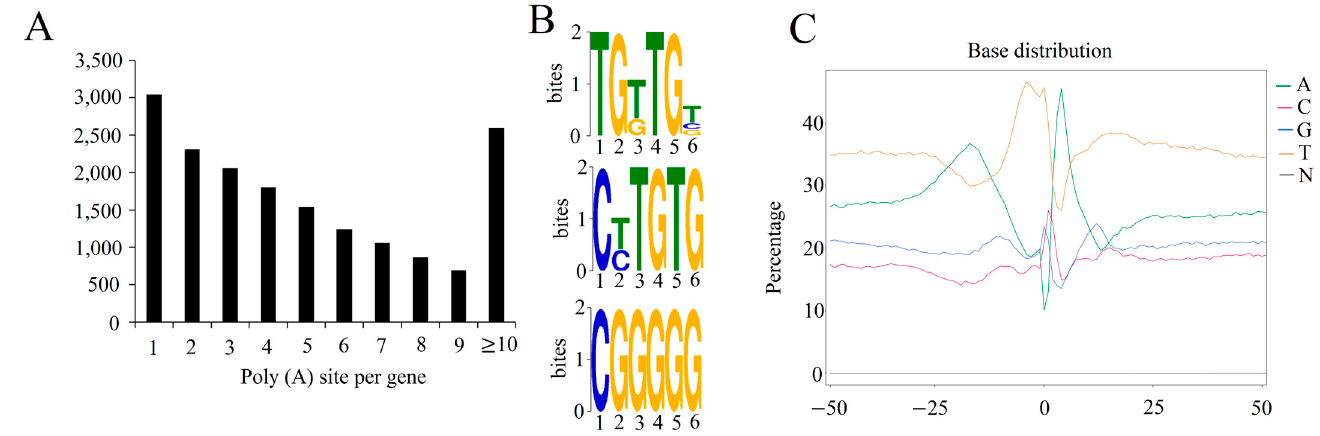
Figure 3. Features of alternative poly(A) sites in Moso bamboo growing culms. ( A ) Quantity of poly(A) sites per gene. ( B ) Three typical poly(A) signals identified by MEME in the moso bamboo genome. ( C ) The nucleotide composition profile around poly(A) cleavage sites.